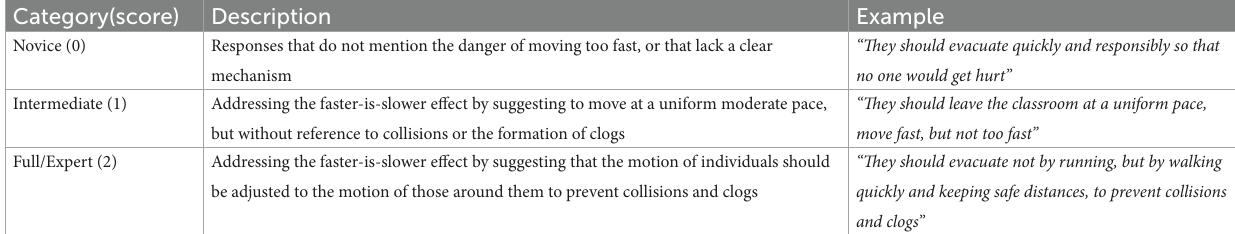
TABLE 1 Categorization and scoring of student answers for question 8.